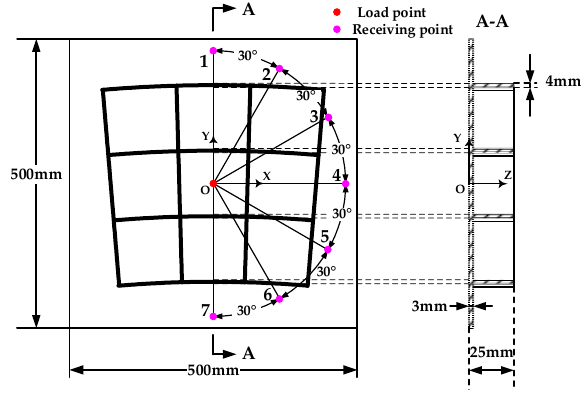
Figure 4. The schematic diagram of model (absorbing layers are not shown).